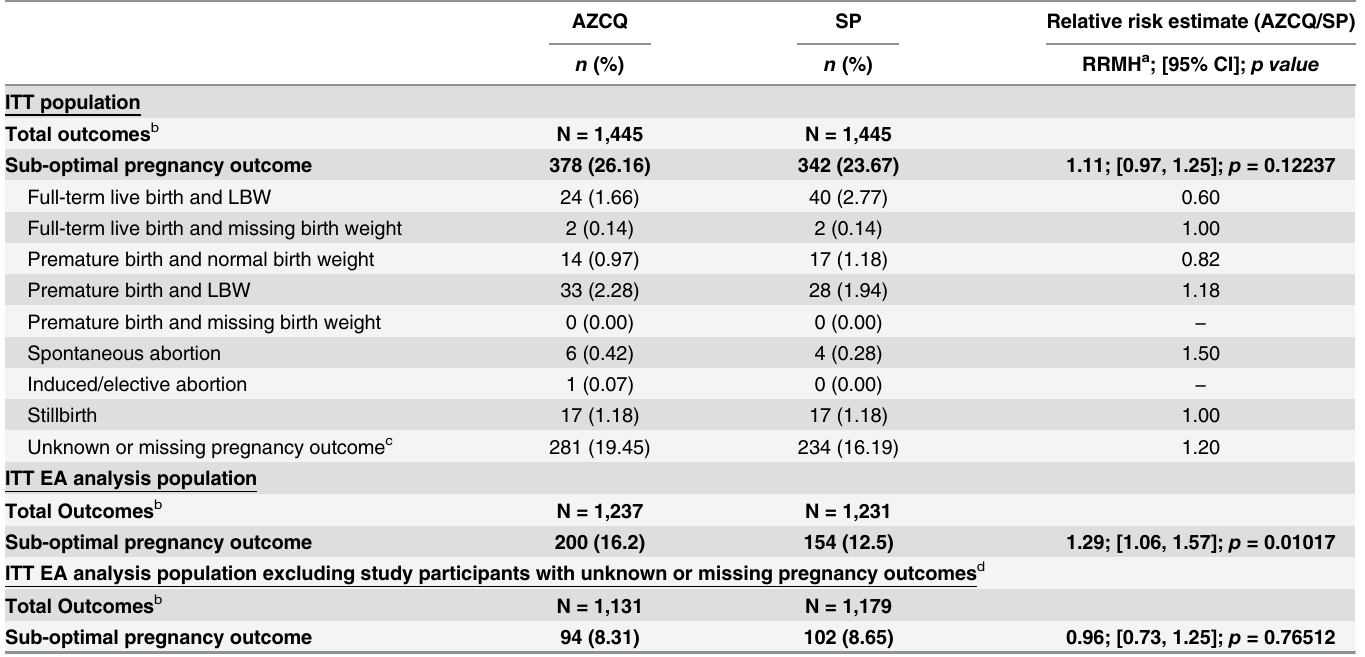
Table 2. Incidence of sub-optimal pregnancy outcome (primary